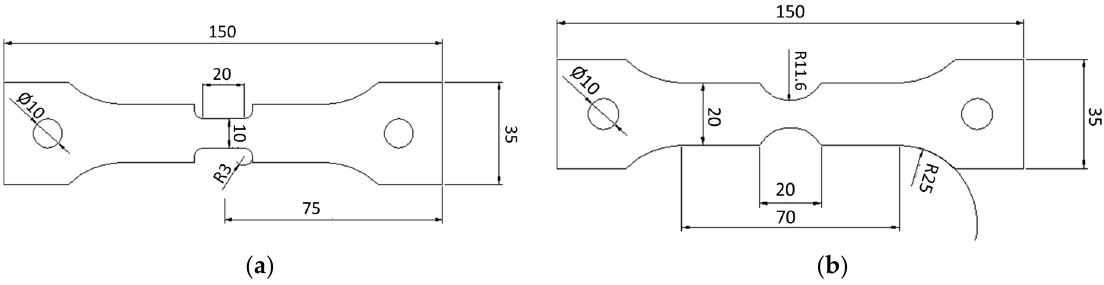
Figure 11. ( a ) Geometry of tapered specimens; ( b ) Geometry of notched specimens.